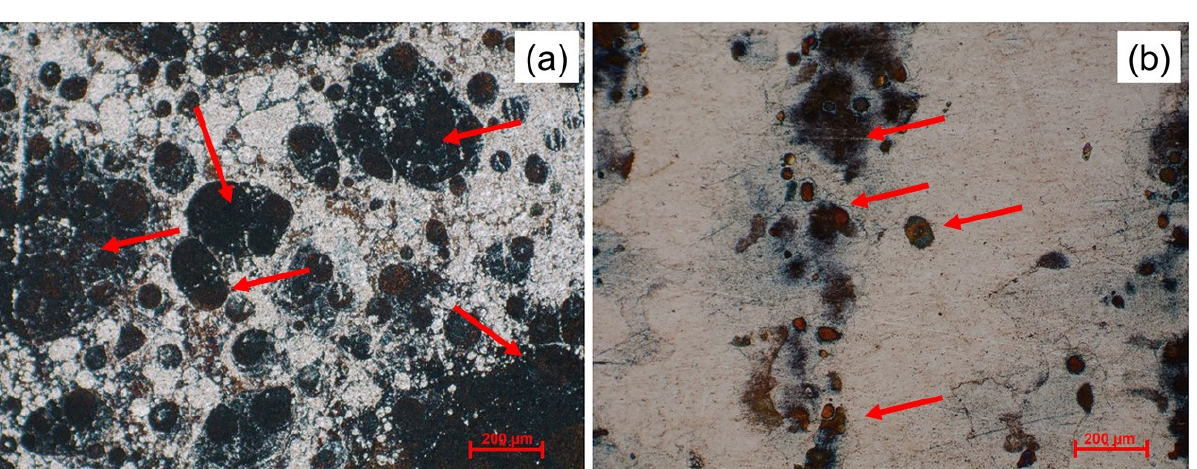
Figure 9. Optical micrographs of the ED-Cr ( a ) and MS-Cr ( b ) coatings after free corrosion test (NSS 144 h). The red arrows indicate the locations of corrosion products. Scale bar 200 µm.